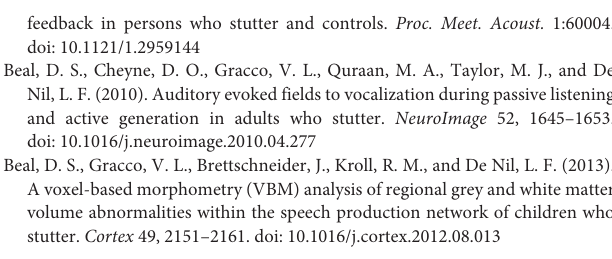
( Figure 5 ): the brain might be increasing the ‘‘gain’’ in a noisy sensorimotor system in order to deal with the demands of